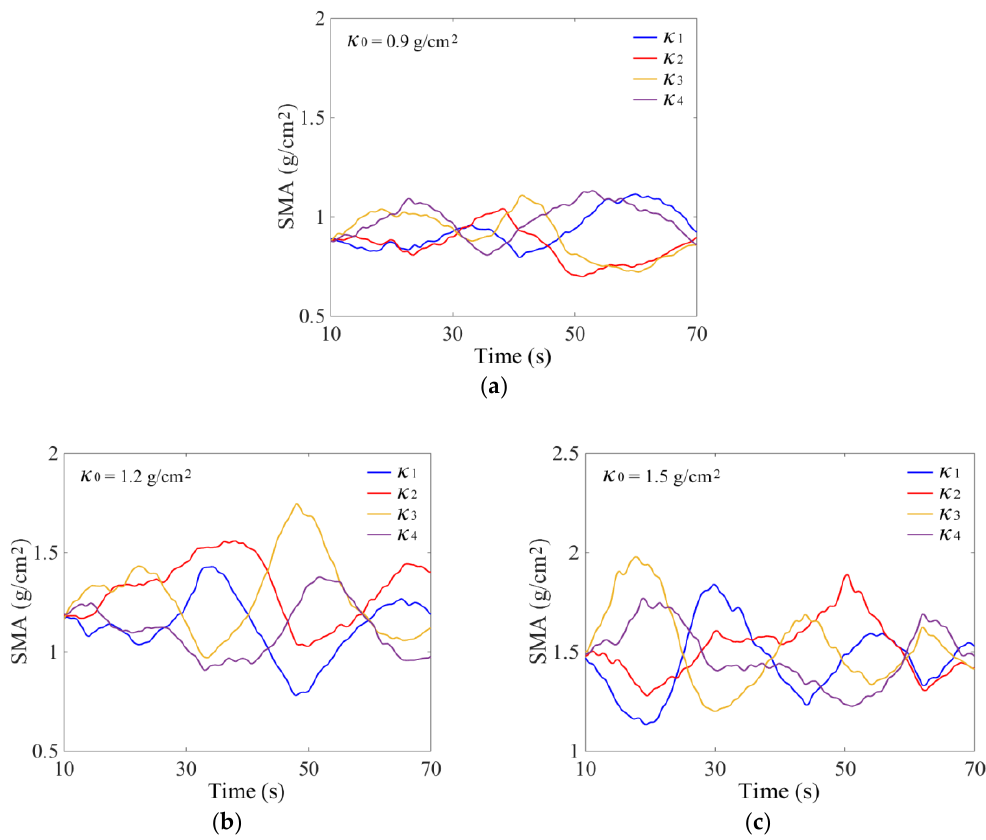
Figure 5. Variations of seeds-mass-per-unit-area (SMA) in four areas: ( a ) Parameters #1; ( b ) Parameters #2; and ( c ) Parameters #3.